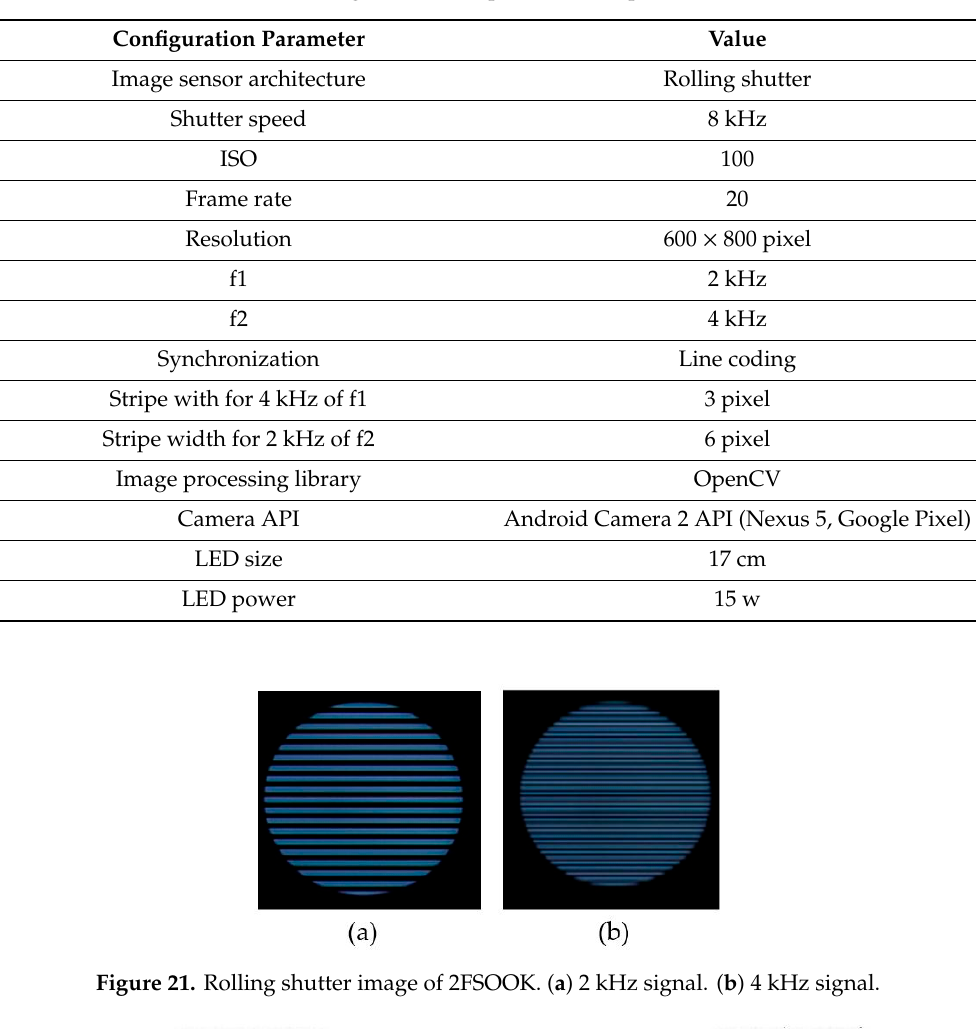
Table 3. Configuration of experimental implementation.